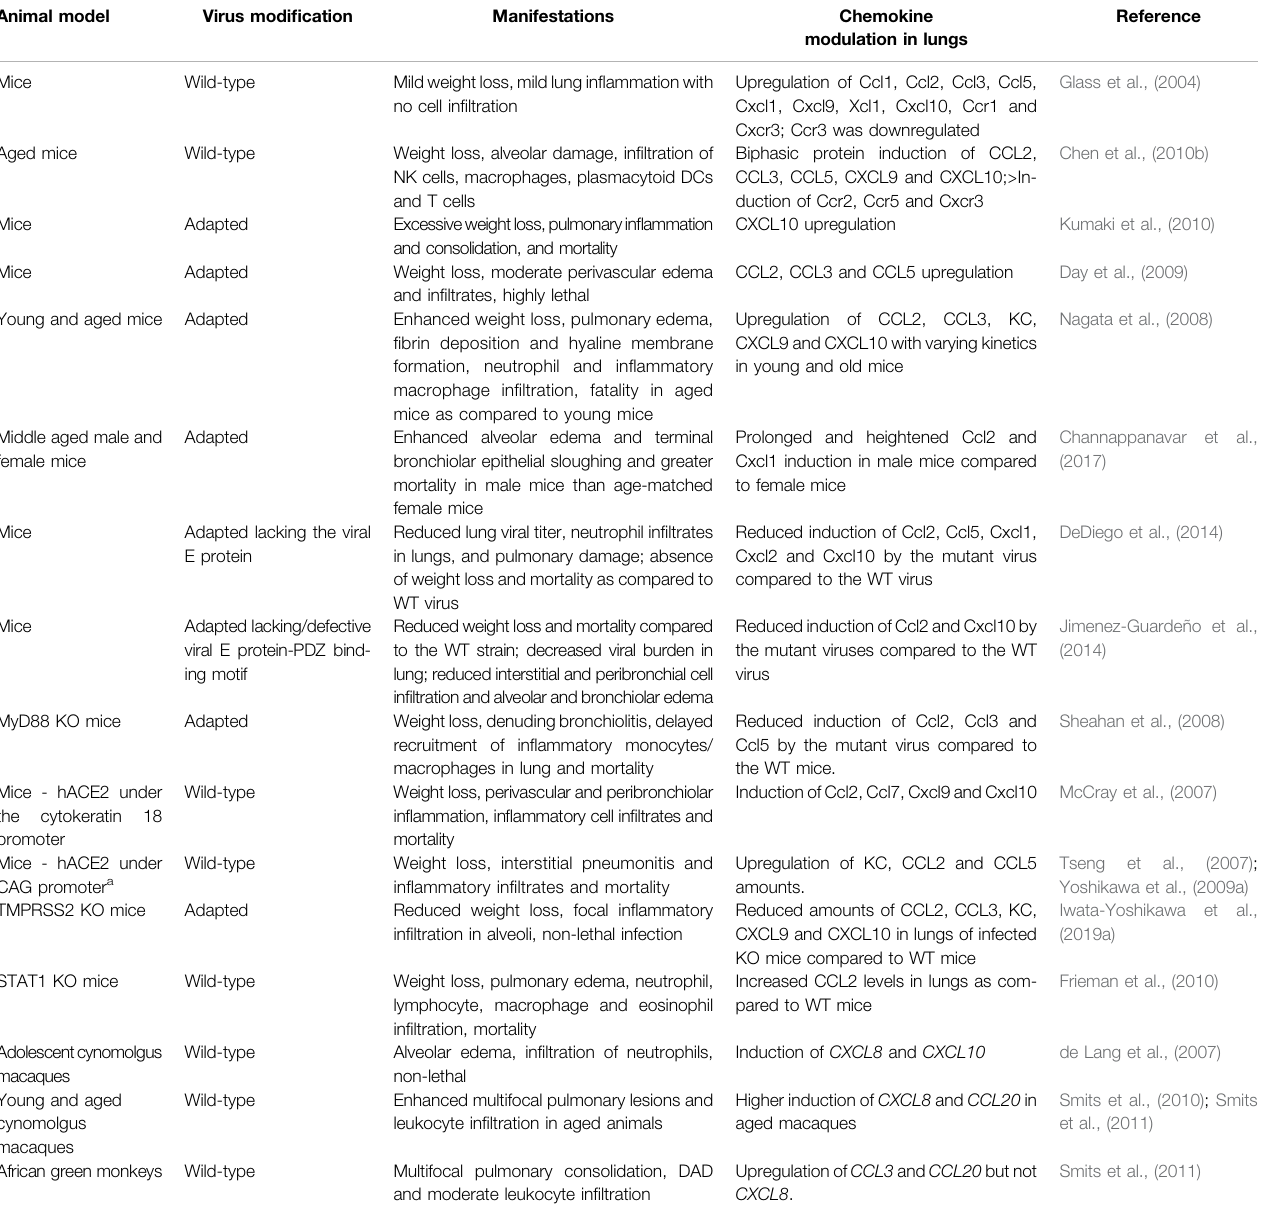
Table 2 | Chemokine modulation in lungs of animal models of SARS-CoV